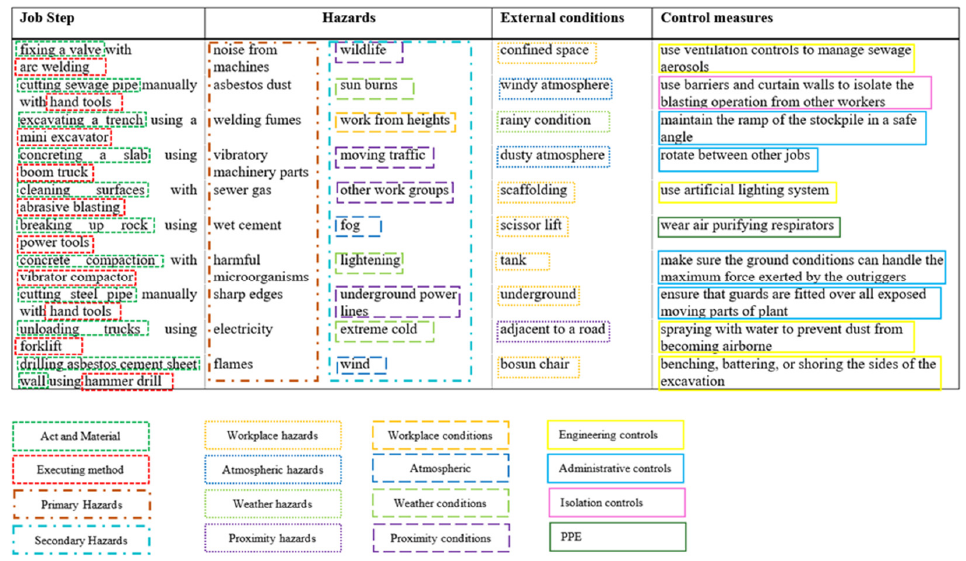
Figure 2. Example of the glossary of terms extracted from JHA documents and the classification of concepts.